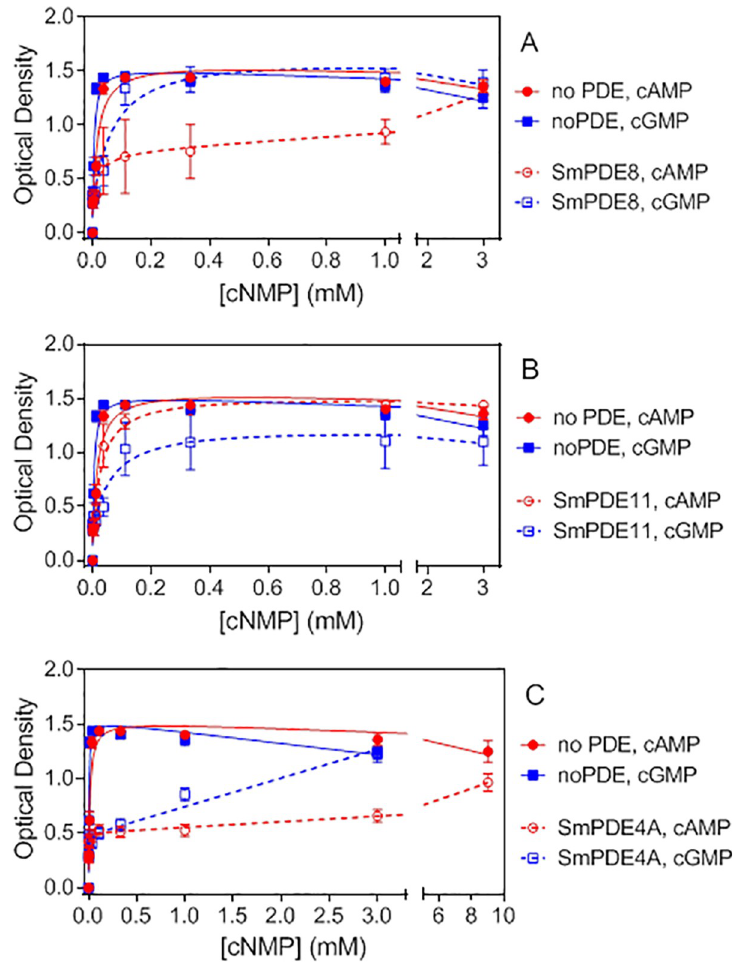
Fig 8. 5FOA-resistant growth of S . pombe strains expressing SmPDE4A, SmPDE8, and SmPDE11 in response to exogenous cAMP or cGMP. 5FOA-resistant growth is due to PKA-mediated repression of an fbp1-ura4 reporter in these strains. A) Growth response curves to varying doses of cAMP or cGMP in strains expressing SmPDE8 as compared to a strain devoid of PDE activity. B) As frame A, for SmPDE11. C) As frame A, for SmPDE4A. Values represent means and standard errors for three to five independent assays for each